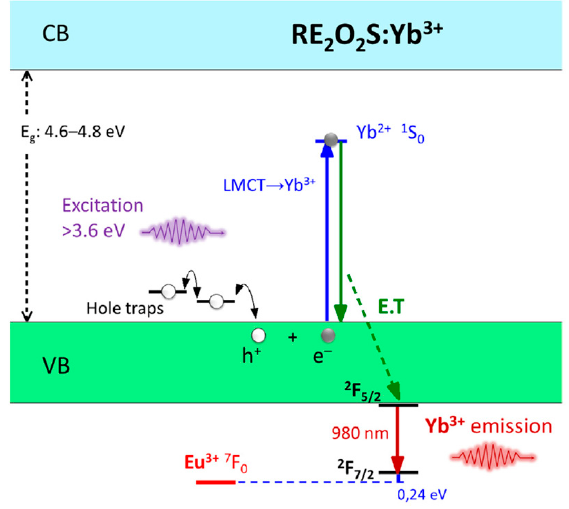
Figure 7. Yb 3 + -activated persistent luminescence mechanism in rare earth oxysulfides. Reproduced from [151] with permission from Elsevier.